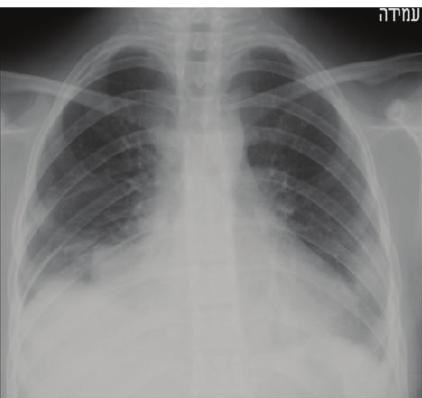
Figure 1: Enlarged perihilar lymph nodes and bilateral lower lobe consolidation.